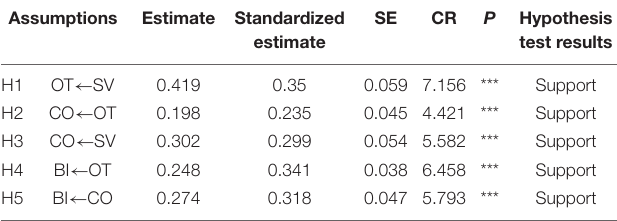
TABLE 5 | Analysis of normalized path